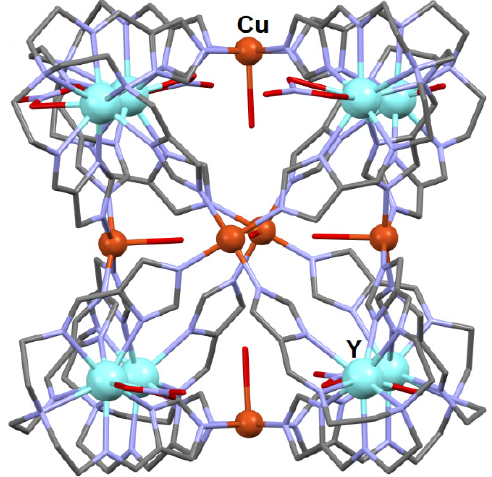
Figure 9. The crystal structure of the cationic cage [Cu 6 Y 8 L 8 (NO 3 ) 5 (H 2 O) 3 ] 7+ [112].